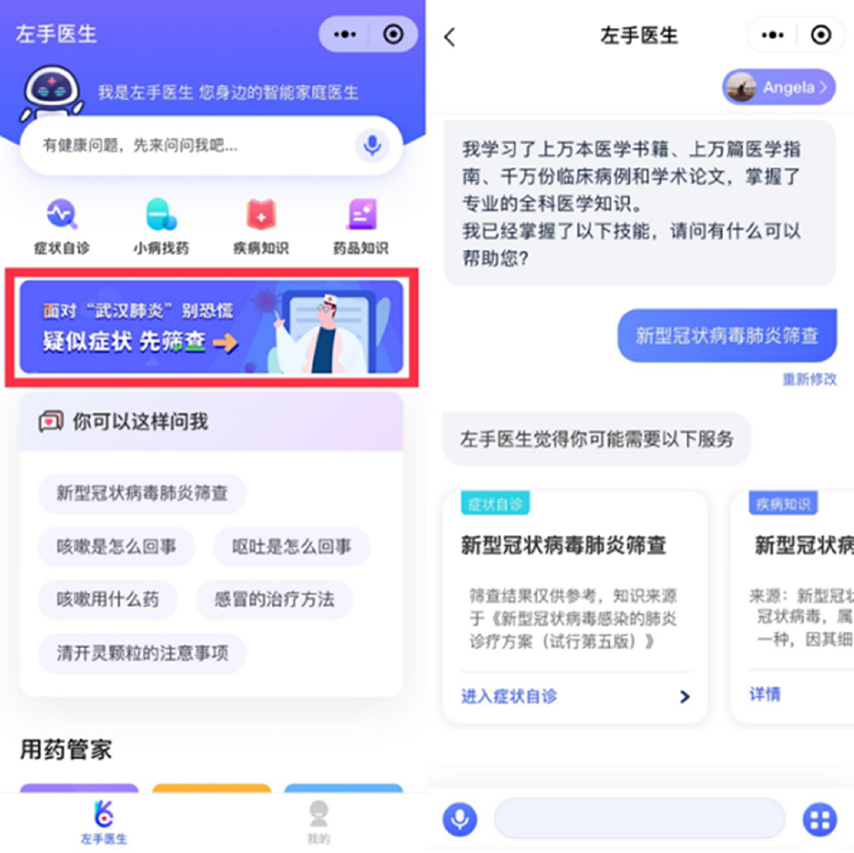
Figure 15. Epidemic consultation page sample.